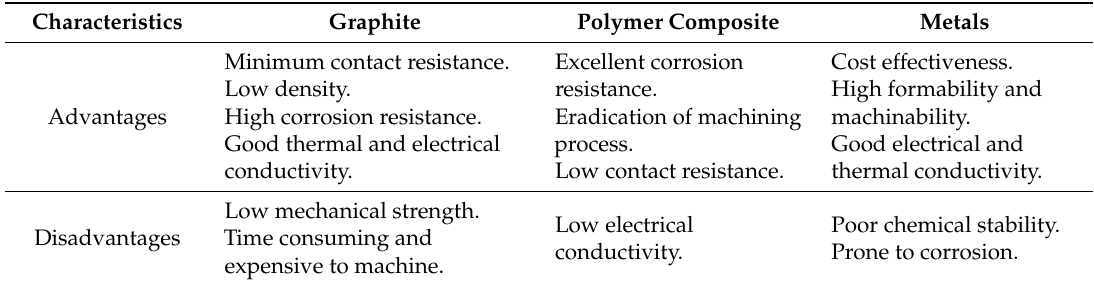
Table 2. Properties of various types of bipolar plates for PEM fuel